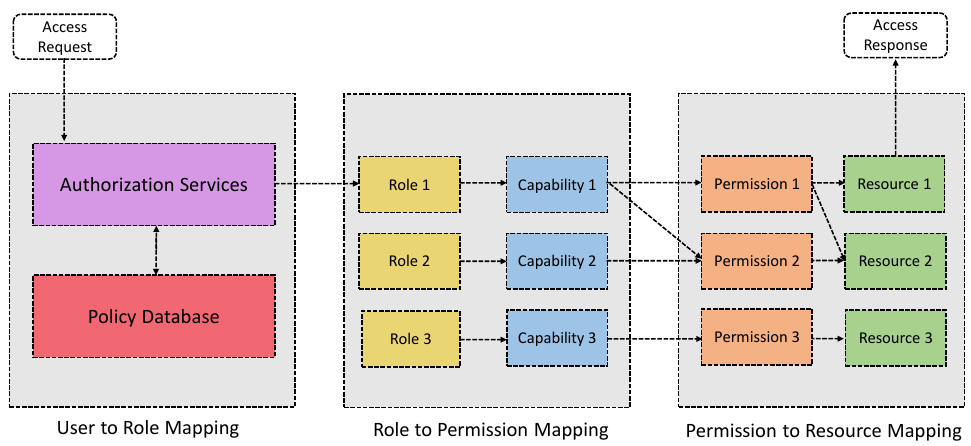
Figure 7. The proposed HyBAC model and information flow among entities presented in